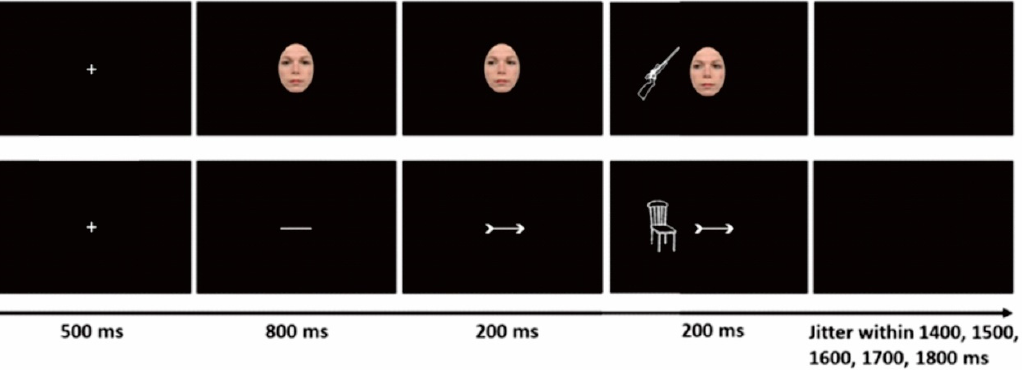
Figure 2. Schematic presentation of the experiment procedure (( Top ): gaze-cue trial; ( bottom ): ar- row-cue